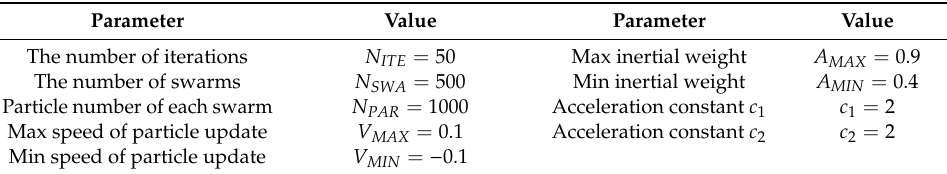
Table 4. Parameters of Algorithm 3 in Figure 13.